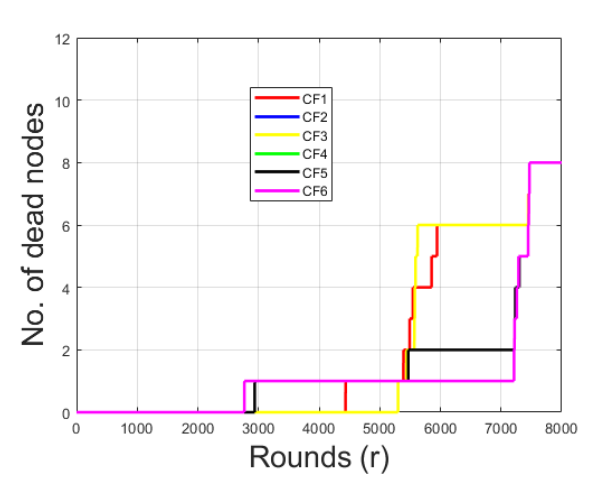
Fig. 5. Packets dropped